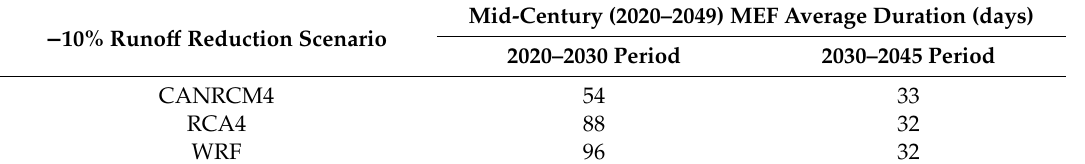
Table 3. Duration of the MEF under historical and − 10% runoff scenarios.